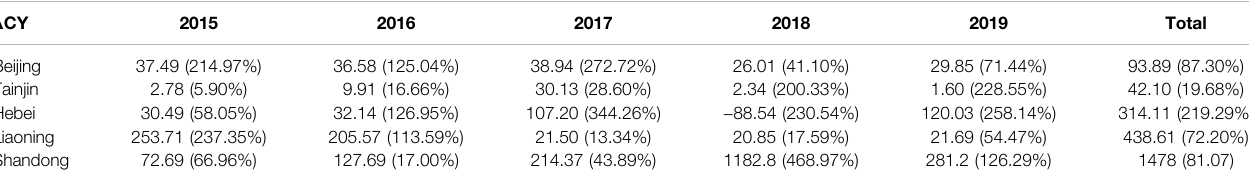
TABLE 5 | Scale effect of carbon emission in provinces and cities.